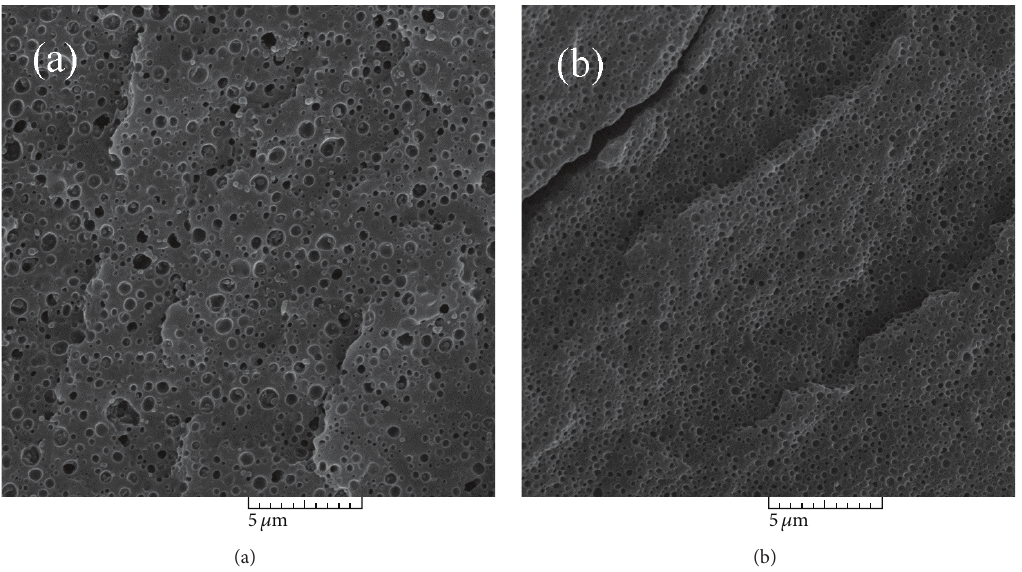
Figure 1: SEM images of the fracture surface of (a) M6 sample and (b) N1 sample.